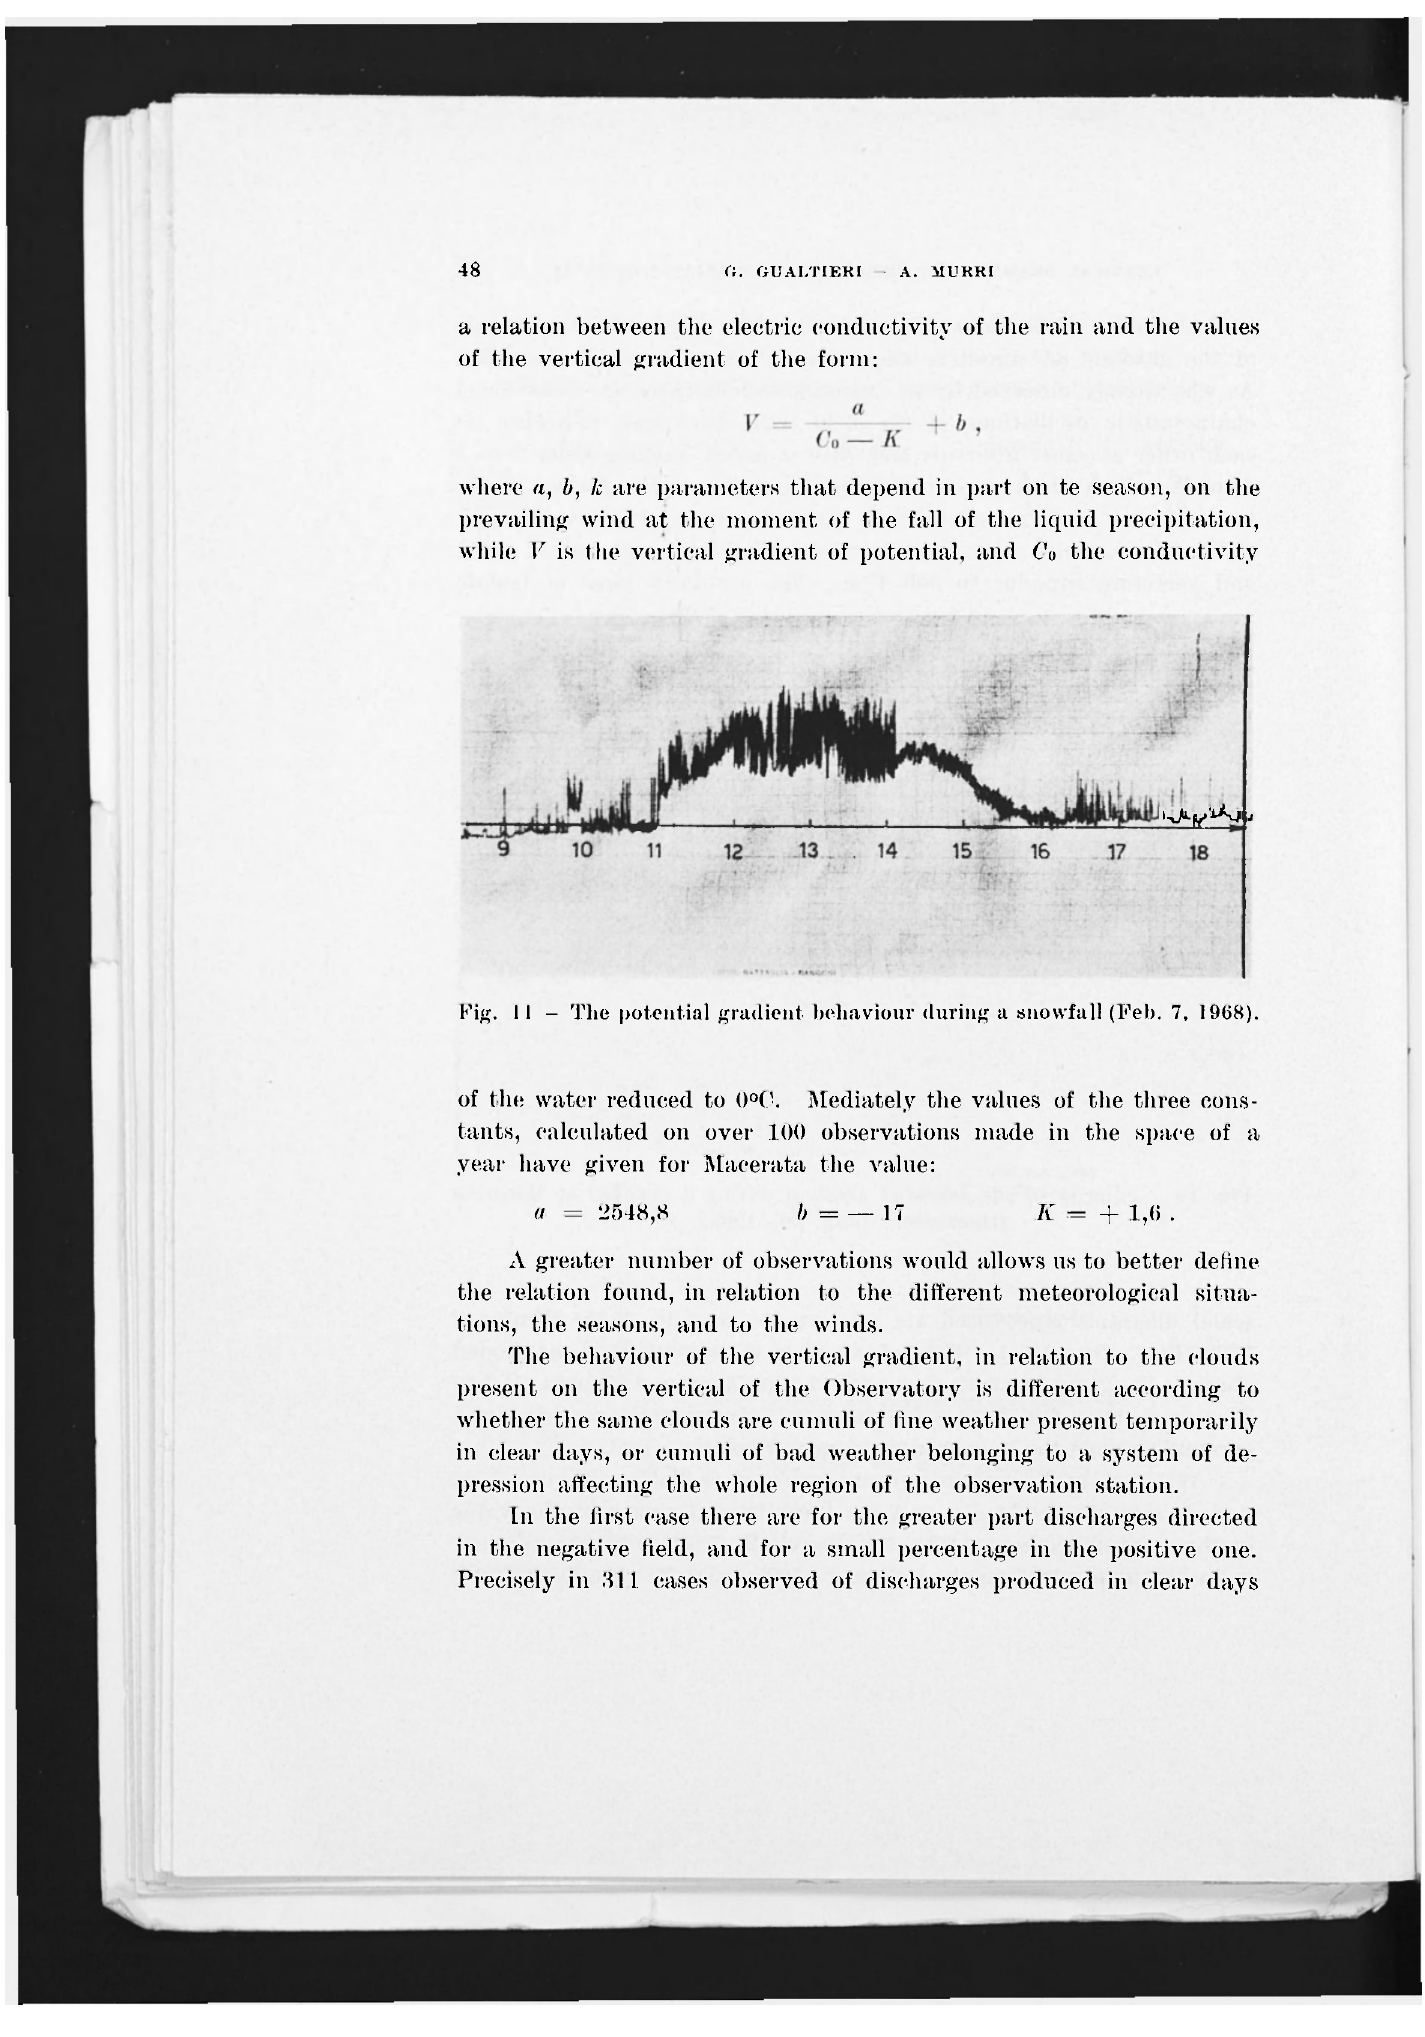
of the water reduced to 0 °C. Mediately the values of the three